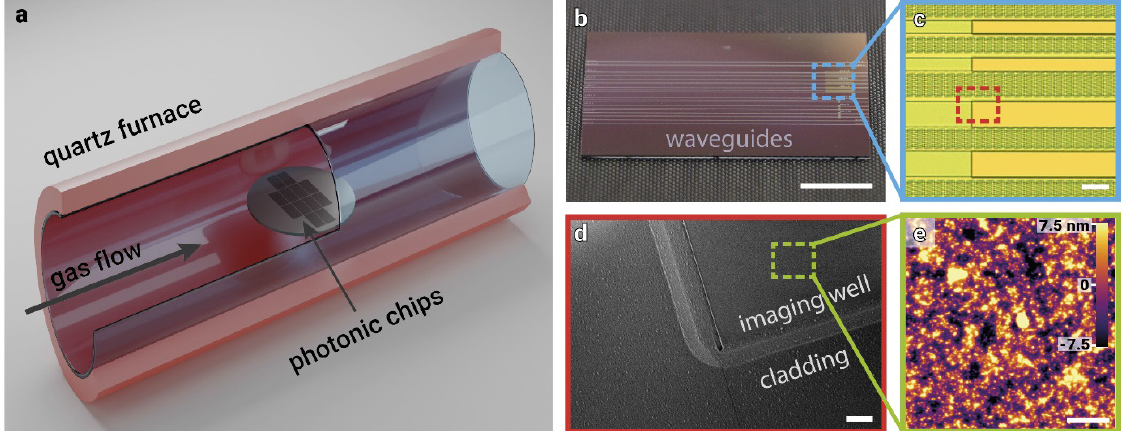
Figure 22. Direct growth of hBN on silicon nitride photonic chips. ( a ) Furnace for CVD growth of few-layer hBN with loaded silicon nitride substrates. ( b ) Single 10 × 20 mm chip with multiple silicon nitride waveguides, running horizontally across the whole chip. Scale bar: 5 mm. ( c ) Optical micrograph of the zoomed-in region from b), showing a number of imaging wells on waveguides. Scale bar: 100 μ m. ( d ) Scanning electron microscope (SEM) micrograph of a zoomed-in area next to the imaging well (dashed rectangle in c) after the growth. Scale bar: 20 μ m. ( e ) AFM image of the directly grown few-layer hBN film on silicon nitride. Scale bar: 2 μ m [82].